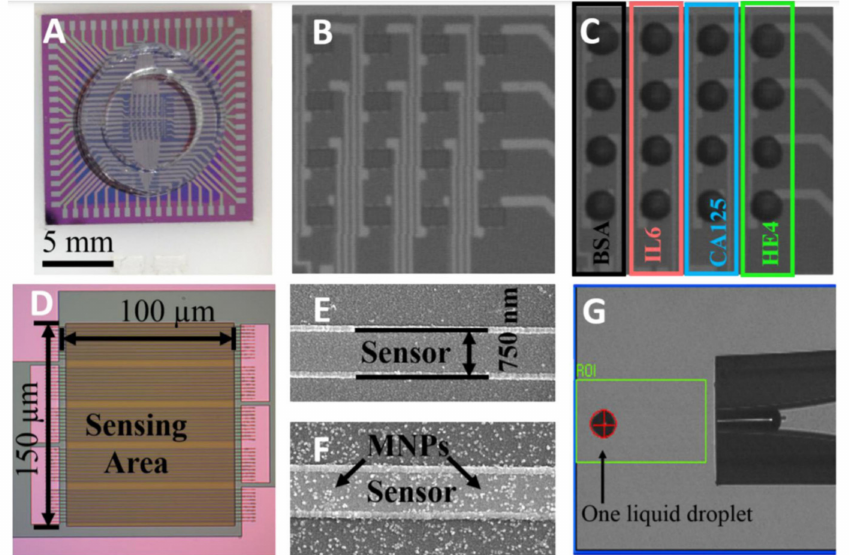
Figure 15. ( A ) The proposed GMR chip in [134]. The sensor array ( B ) before and ( C ) and after putting the samples on the chip. ( D ) A zoomed view of the sensors. SEM images of one GMR sensor strip ( E ) before and ( F ) after magnetic nanoparticles bound to its surface. ( G ) A piezo dispense capillary is used to dispense nanoparticles. Reprinted with permission from T. Klein, et al., 2019. Biosensors and Bioelectronics 126, 301-307 [134]. Copyright 2020 Elsevier.